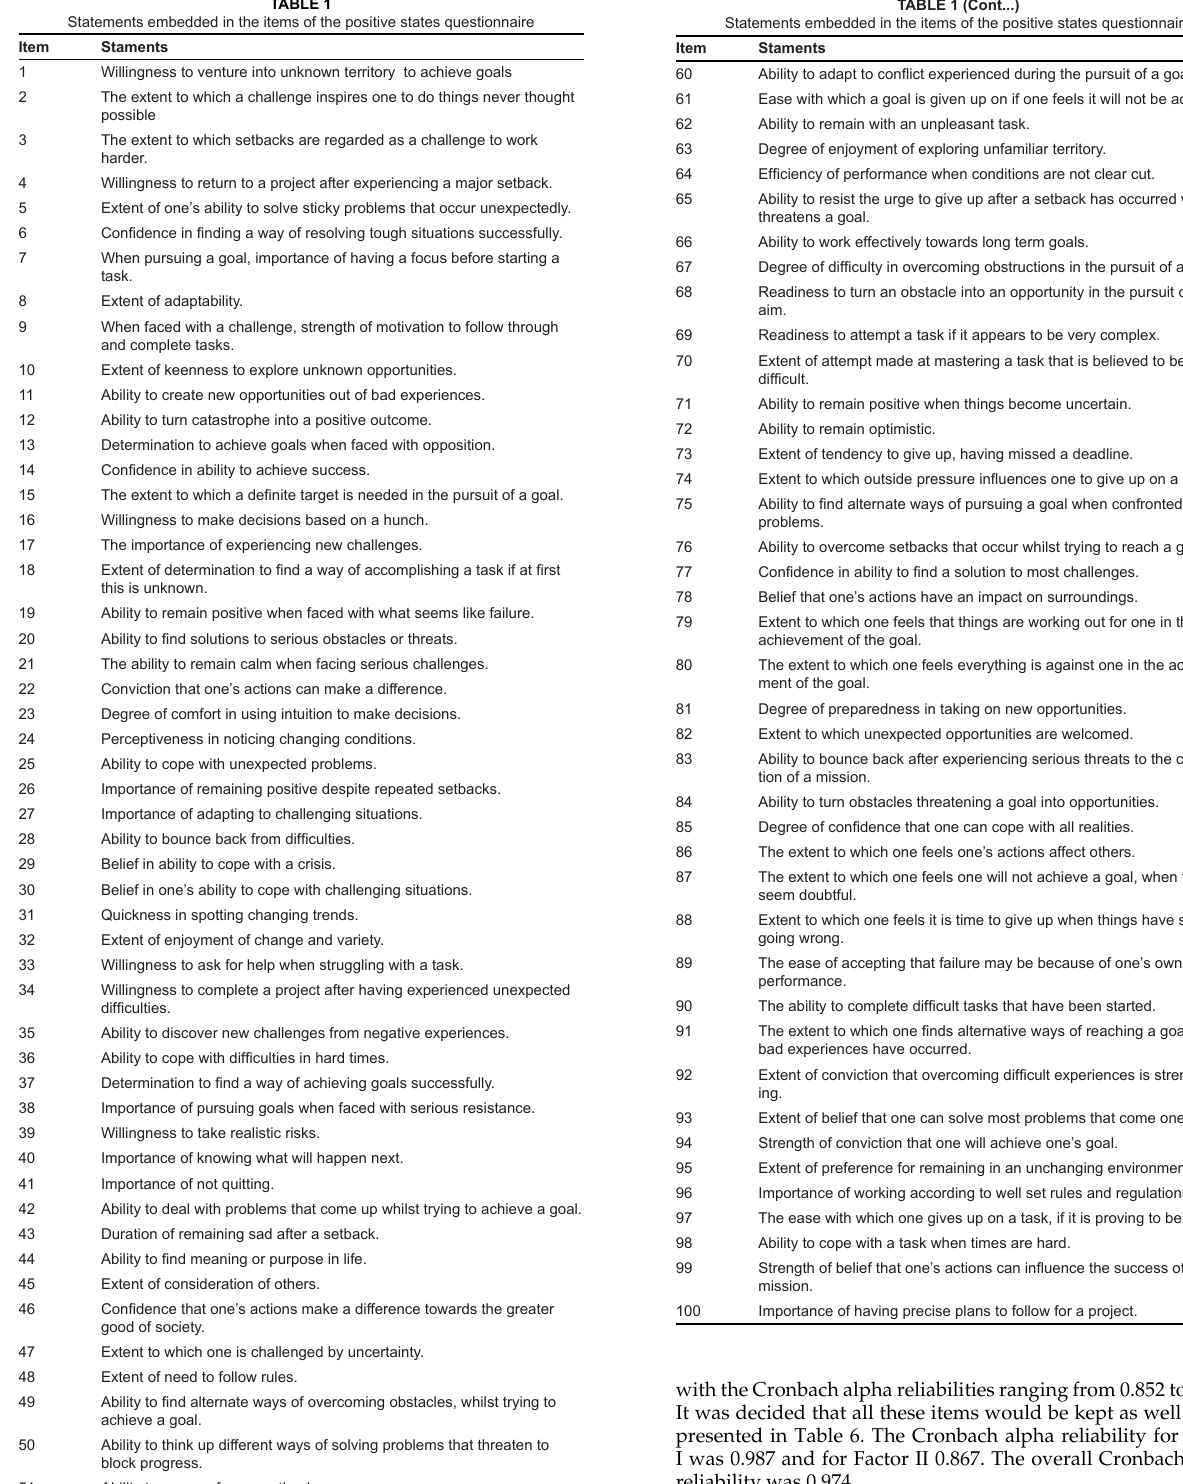
TABLE 1 (Cont...) Statements embedded in the items of the positive states questionnaire Item Staments 60 Ability to adapt to conflict experienced during the pursuit of a